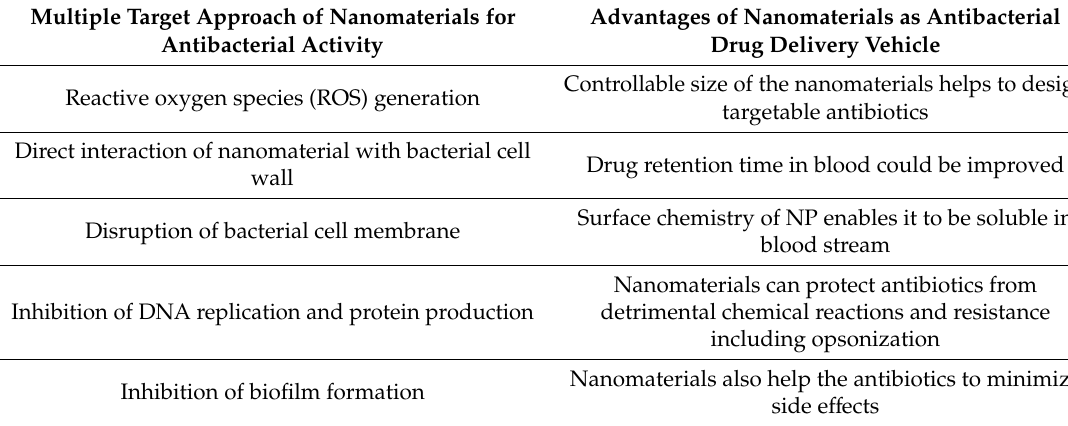
Table 1. Advantages of nanomaterials (NPs) for antibacterial